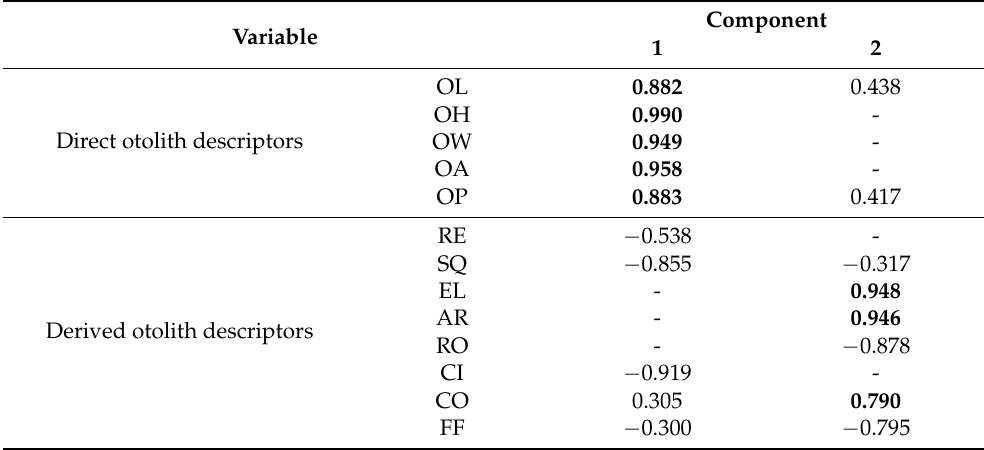
Table 5. Rotated component matrix extracted from all descriptors using Principal Component Analysis (PCA).